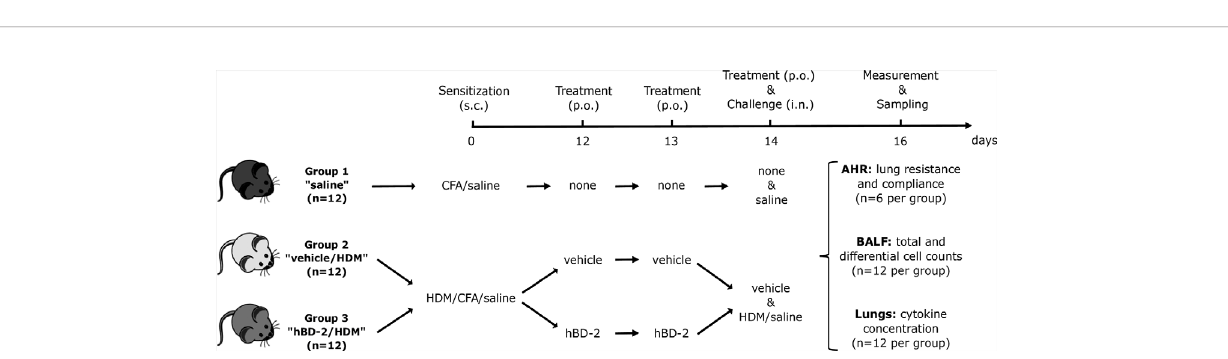
FIGURE 3 | Prophylactic administration of hBD-2 in BALB/c mice and grouping according to sensitization and treatment. Challenge was carried out 1 h after the last dose of saline or vehicle on day 14. AHR, airway hyper-reactivity; BALF, bronchoalveolar lavage fl uid; CFA, Complete Freund ’ s Adjuvant; hBD-2, human beta- defensin 2; HDM, house dust mite; i.n. , intra-nasal; p.o. , per oral; s.c. ,